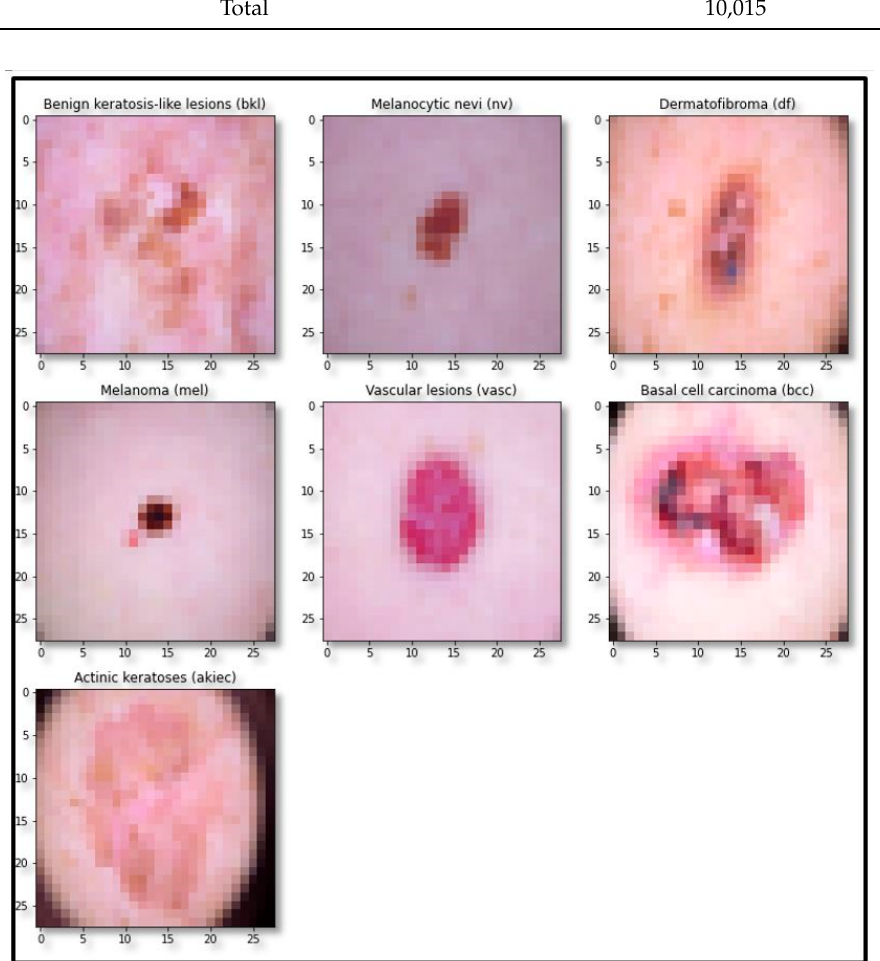
Figure 1. Sample images of each class of the dataset.